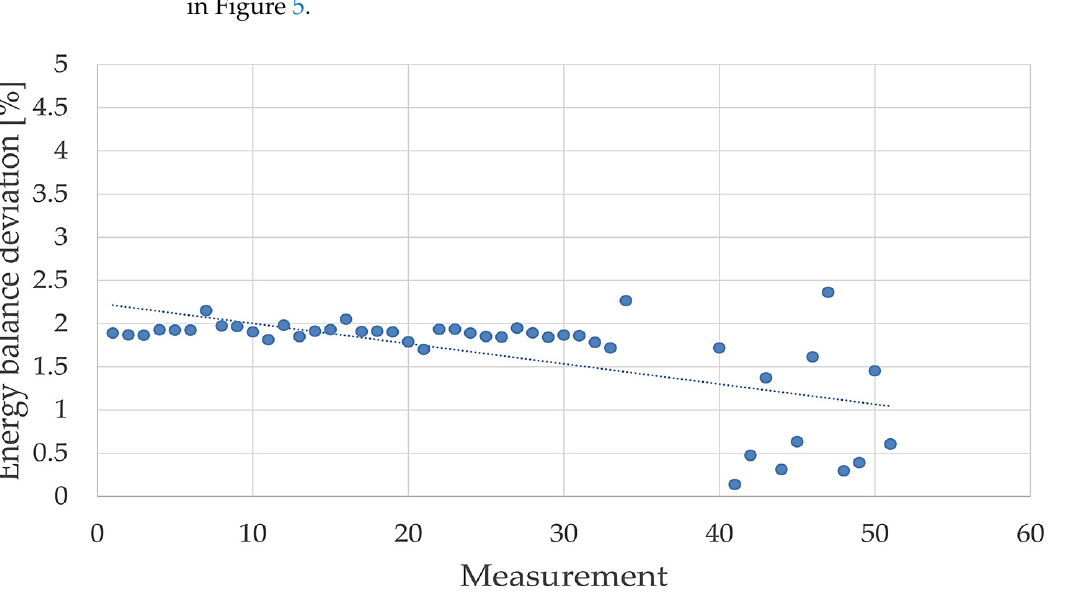
Figure 5. Energy balance deviation. According to Equation (3), the specific heat flux transferred to the evaporator is calculated by dividing the total flux necessary for ammonia boiling to the total surface of heat transfer extracted from Table